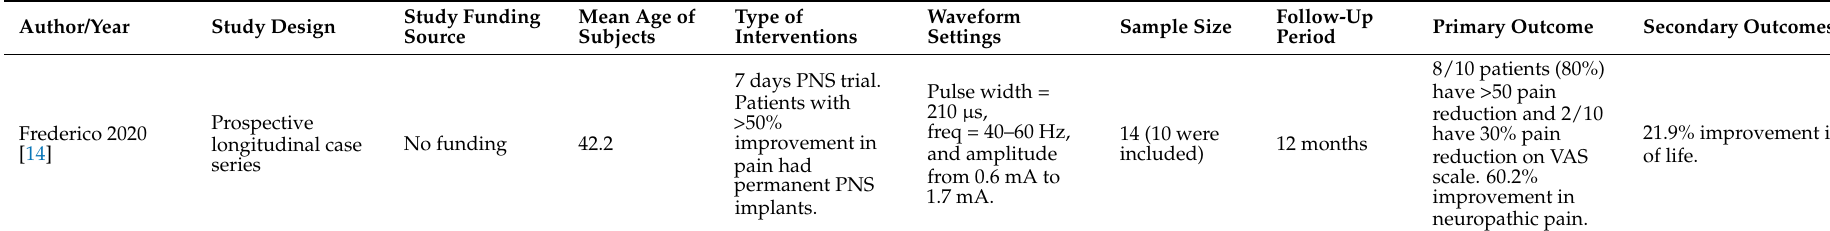
Table 1. Summary of